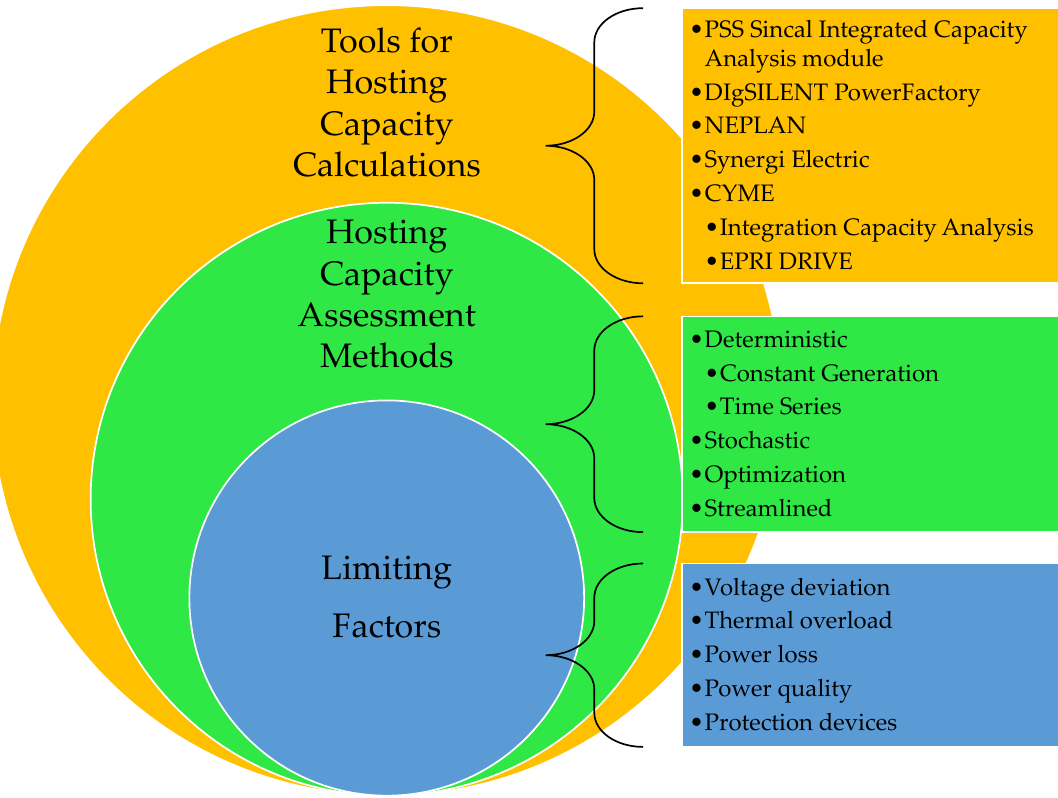
Figure 2. Overview of the review structure.